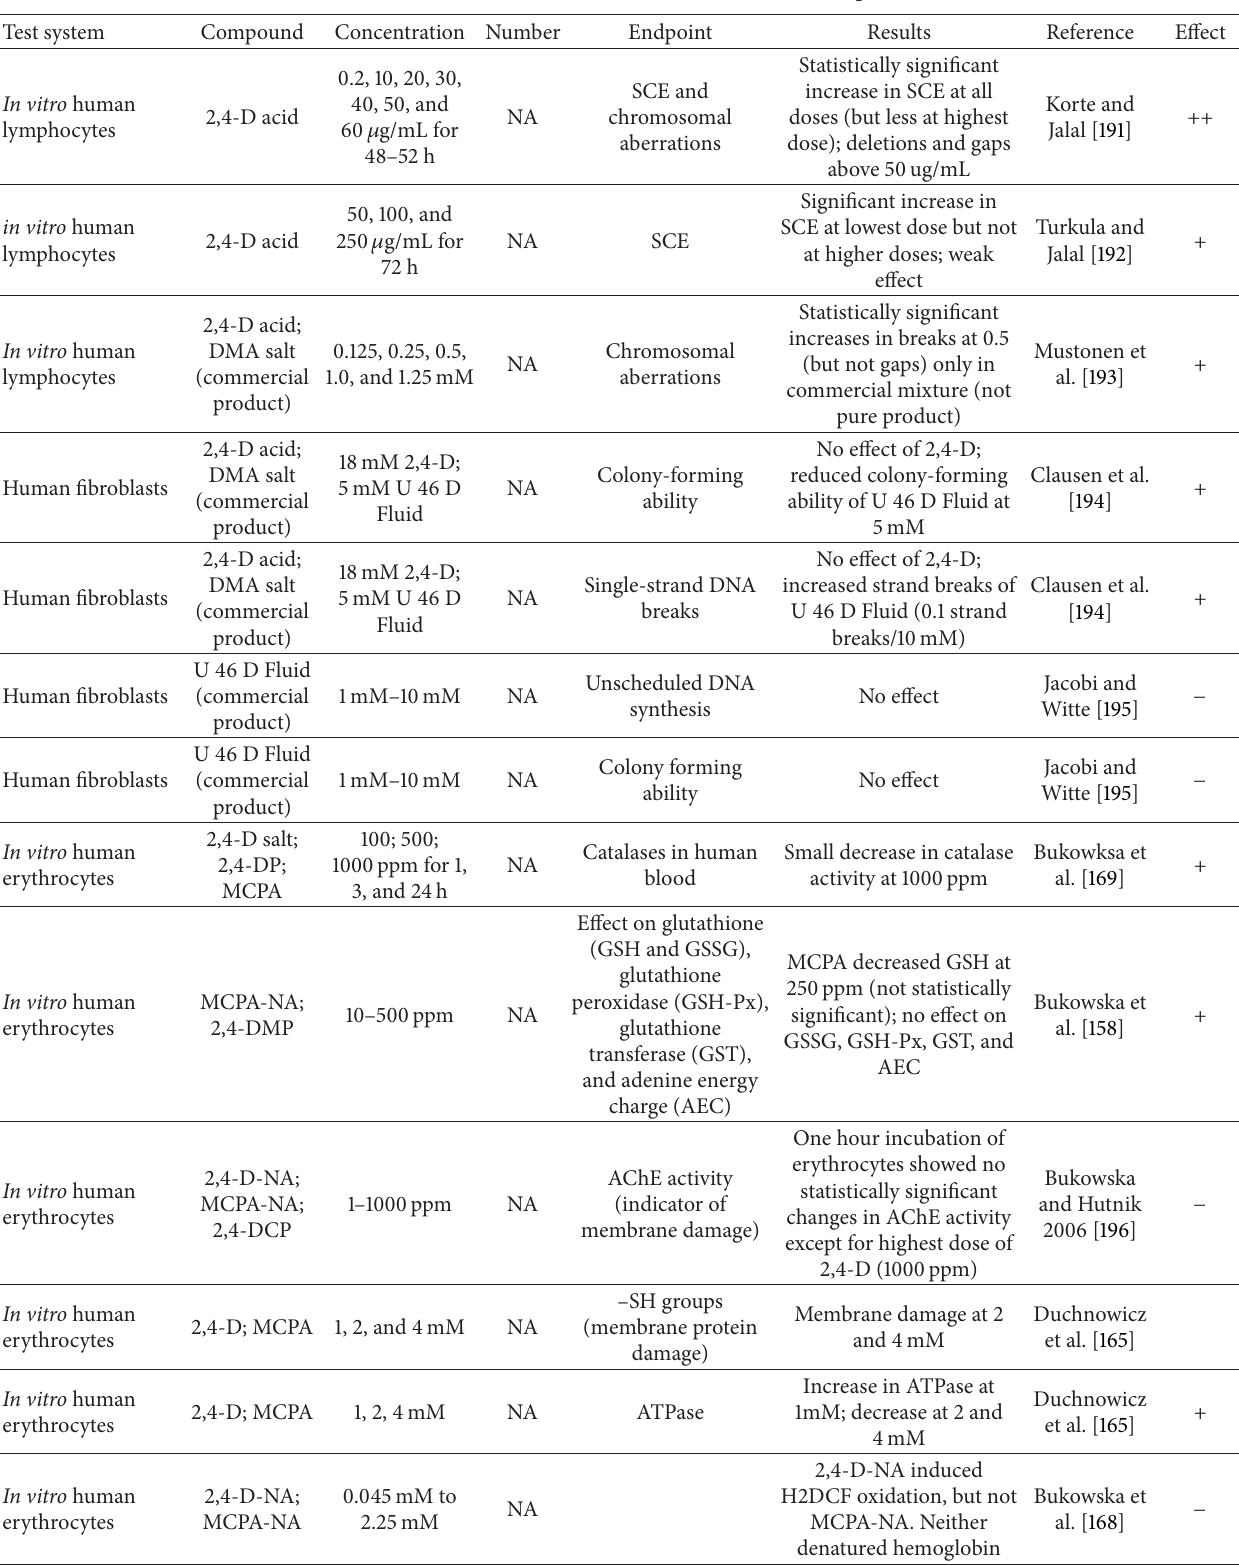
Table 8: Studies in human cell cultures in vitro or humans exposed in vivo